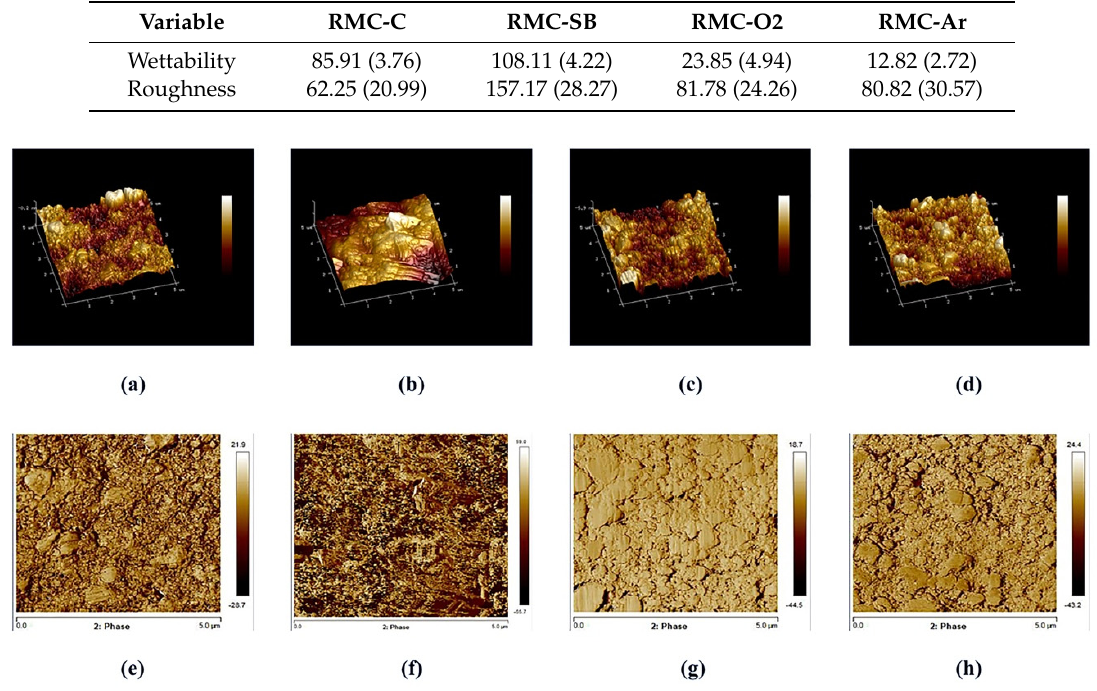
Figure 4. AFM 3D and 2D images of the surface roughness in representative specimens of RMC: ( a , e ) control group; ( b , f ) sandblasting; ( c , g ) plasma O2; ( d , h ) plasma argon.